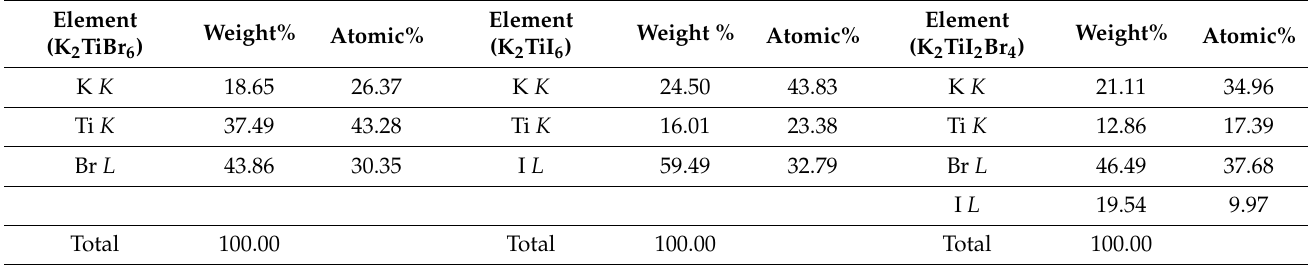
Table 1. Energy dispersive X-ray analysis of K 2 TiI 6 , K 2 TiBr 6 and K 2 TiI 2 Br 4 .